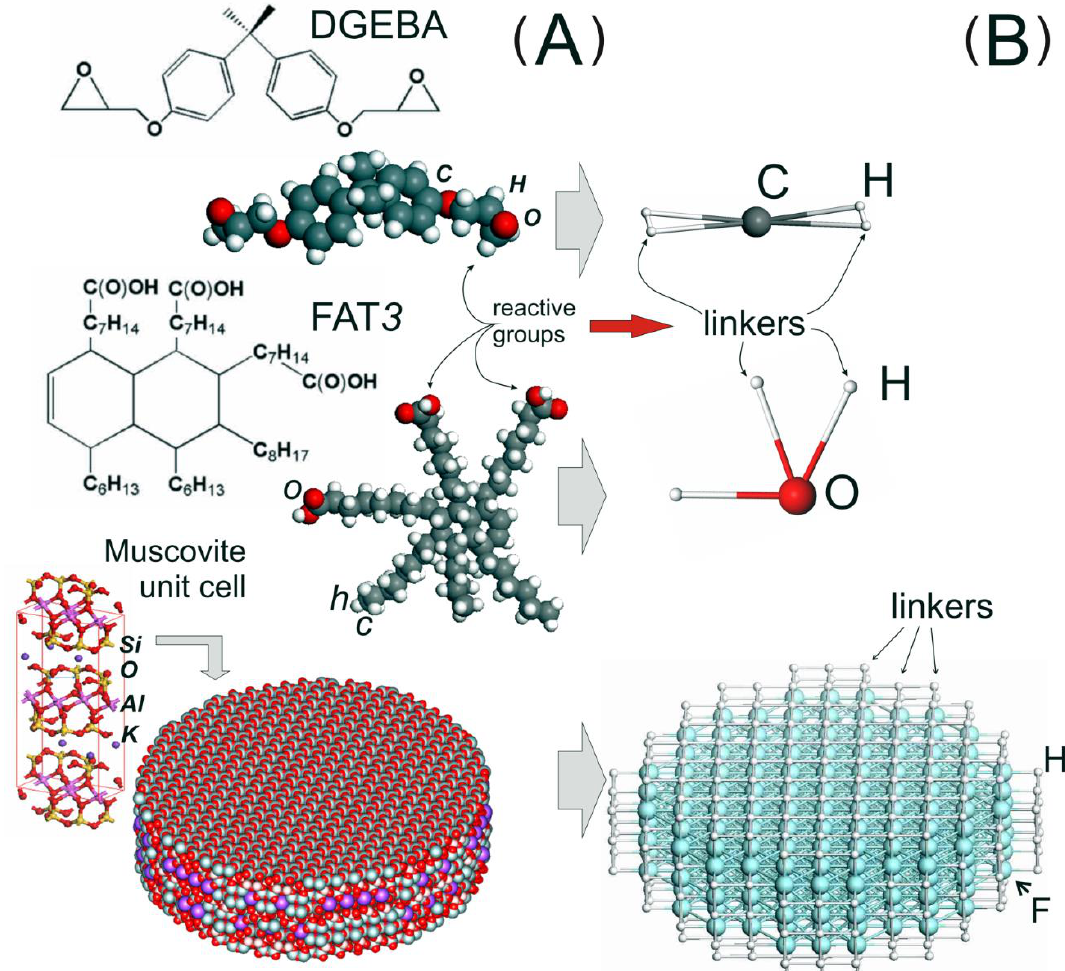
Figure 1. ( A ) Chemical structures and atomistic models of epoxy resin: diglycidyl ether of bisphenol-A (DGEBA), hardener: tricarboxylic fatty acids (FAT3) and muscovite (H, C, O, Si, K, and Al are the names of chemical elements). ( B ) The corresponding coarse-grained models. We use composite beads, which consist of conventional DPD beads and semi-virtual particles, called linkers, to simulate chemical reactions at the mesoscale level. When we are mapping atomistic structures onto coarse-grained representation, the linkers with the corresponding valence are situated at positions of the reactive atoms. The DPD beads can also be cross-linked to each other to imitate the shape of molecular structures. DPD beads are involved in all types of interparticle interactions. Linkers participate in intramolecular interactions when the bonds and bond angles are deformed. In addition, they can form new covalent bonds. In this part of the figure, C, O, F depict DPD beads and H linkers.